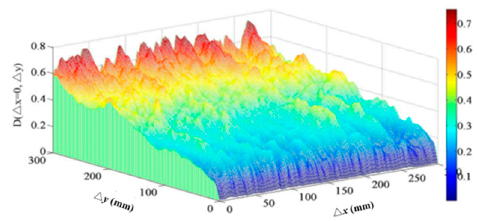
Figure 11. The second-order structure function of the bed elevation when the bed was in the initial state along the transverse direction.